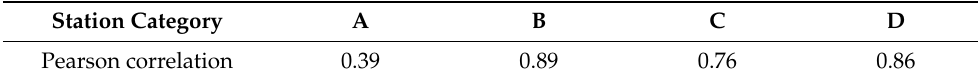
Table 3. Summary of ANOVA and Tukey’s post hoc HSD test for overall mean distance travelled. ANOVA